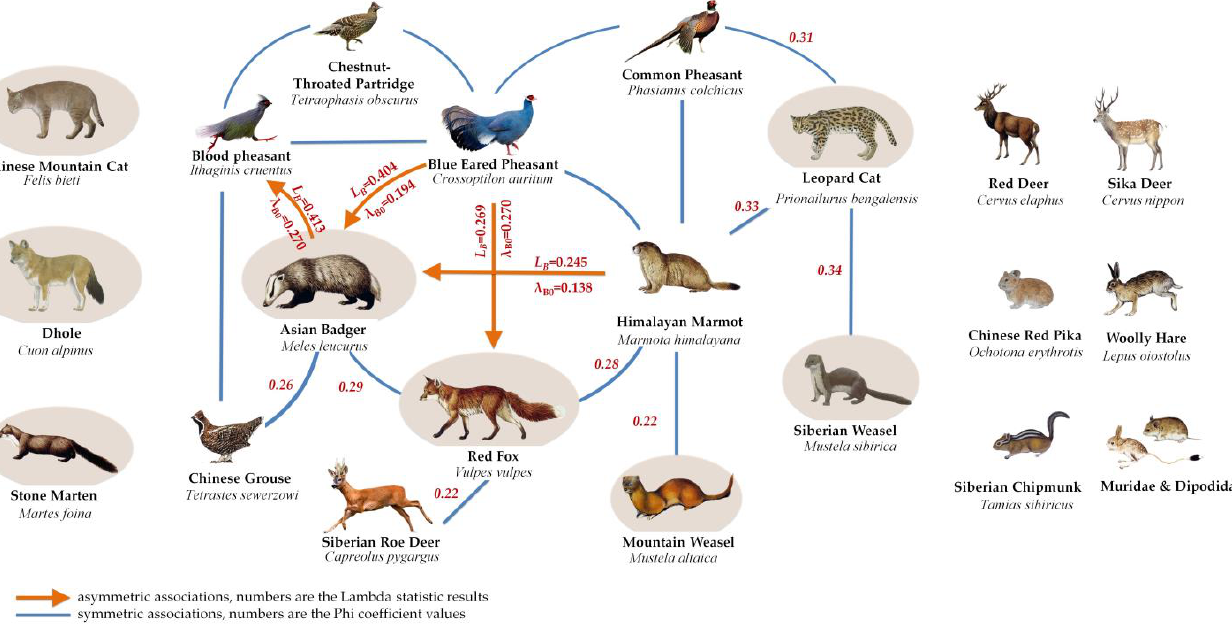
Figure 4. Spatial association network of terrestrial birds and mammals in LNNR.